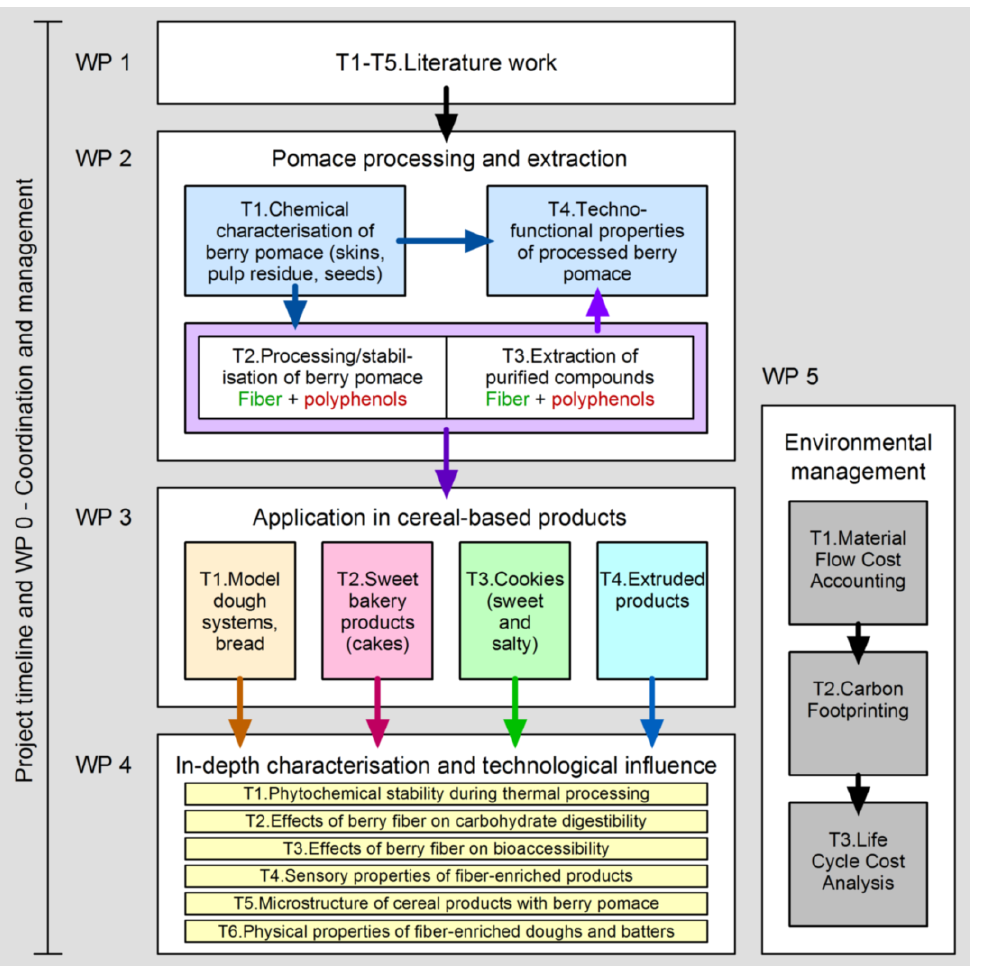
Figure 1. Research agenda of the BERRYPOM project. WP, work package; T,